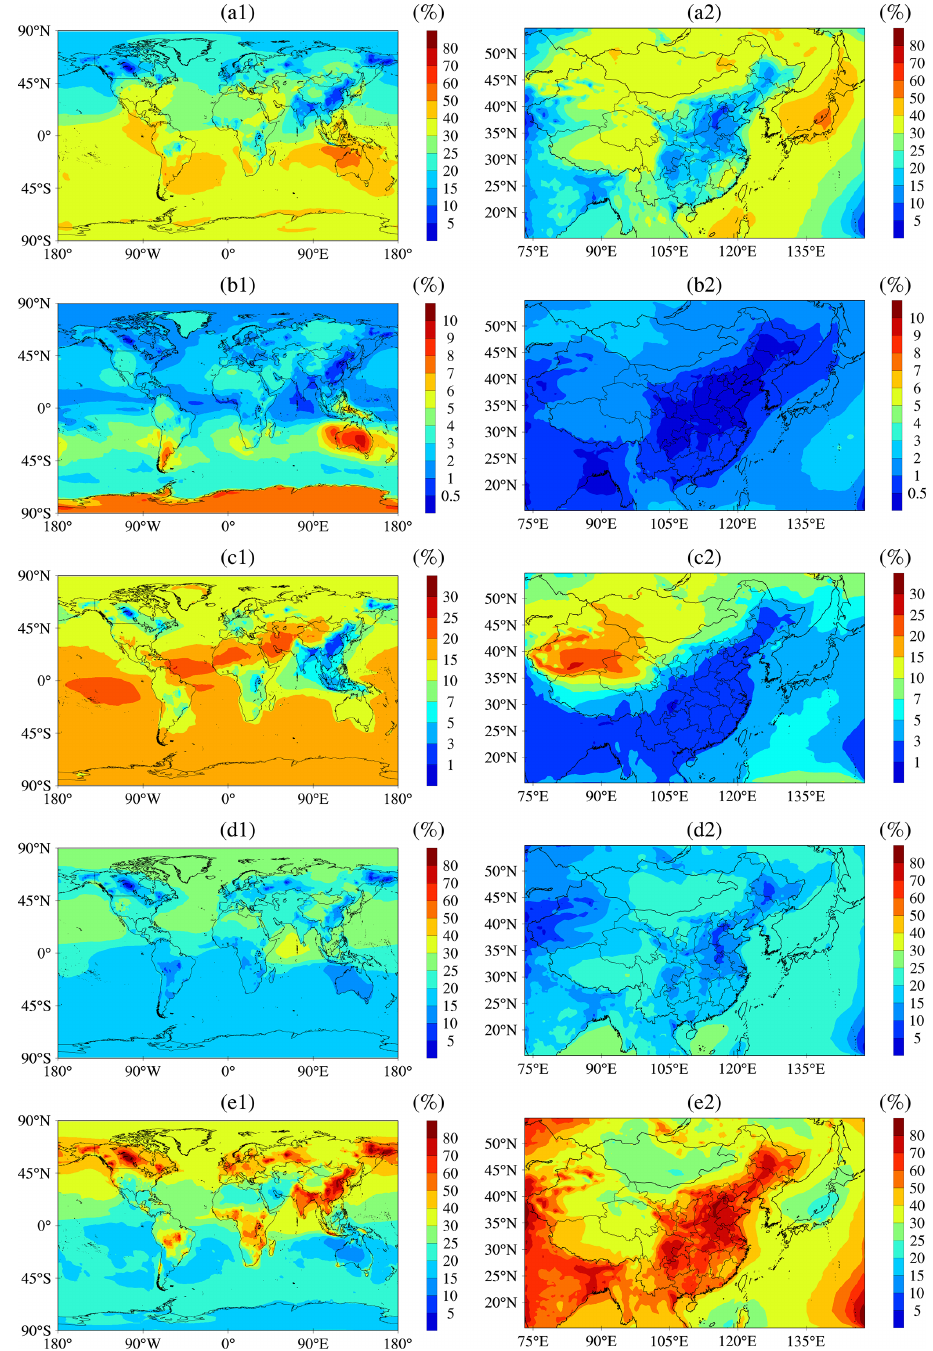
Figure 9. Surface layer horizontal spatial distributions of the fraction of organic species that reside in SPs (a1, a2) , sea salt (b1, b2) , dust (c1, c2) , BC (d1, d2) , and OC (e1, e2) particles over the first domain (a1, b1, c1, d1, e1) and second domain (a2, b2, c2, d2, e2)